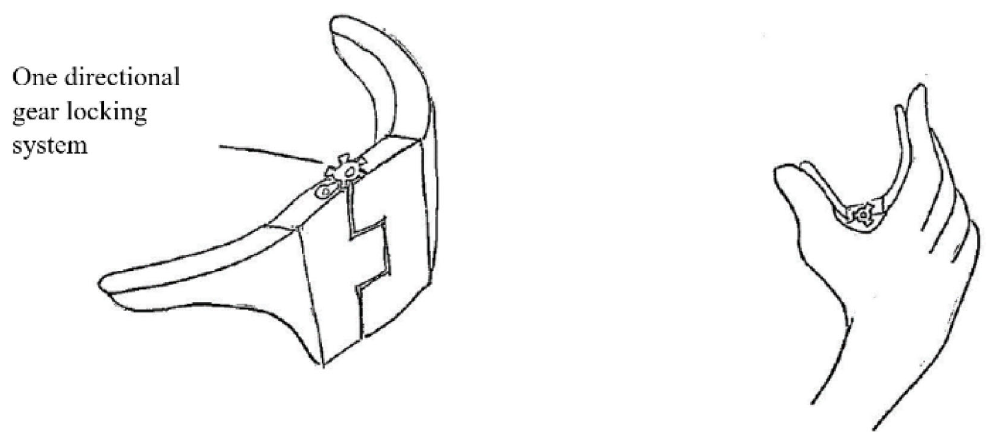
Figure 10. Segmentation concept design.